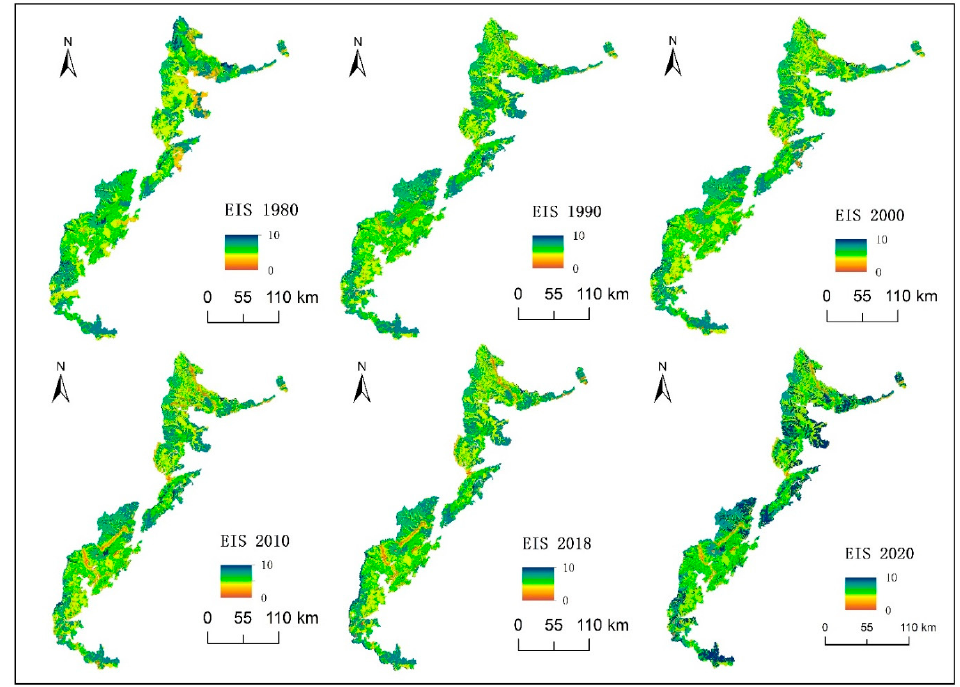
Figure 6. Characteristics of the ecological intactness change of GPNP from 1980 to 2020.